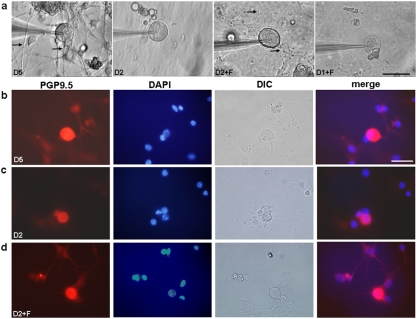
Attachment and growth of DRG neurons on PDMS substrates with defined ECMs.a, Patch recorded DRG neurons cultured on PDMS substrates coated with poly-L-lysine showed no neurite outgrowth in day-2 culture (D2), but extended neurites were observed in day-5 culture (D5). DRG neurons cultured on PDMS substrates coated with fibronectin showed no neurite outgrowth in day-1 culture (D1+F), yet displayed extended neurites in day-2 culture (D2+F). Arrows indicate the neurites. b–d, To distinguish neurons from glial cells, the cells were stained for protein gene product 95. (PGP 9.5), which is an ubiqutin C-terminal hydrolase specifically expressed in most neurons and known to be present in neurites of DRG [40]. b, DRG neurons cultured on poly-L-lysine-coated PDMS substrates for 5 days showed extended neurites and presence of PGP 9.5 (red pseudo-color) along with DIC and DAPI imaging, indicating the cell nucleus (blue pseudo-color). c, PGP 9.5-positive DRG neurons cultured on poly-L-lysine-coated PDMS substrates at day-2 showed no neurite outgrowth. d, PGP 9.5-positive DRG neurons cultured on fibronectin-coated PDMS substrates showed extended neurites at day-2. Scale bar, 50 µm.